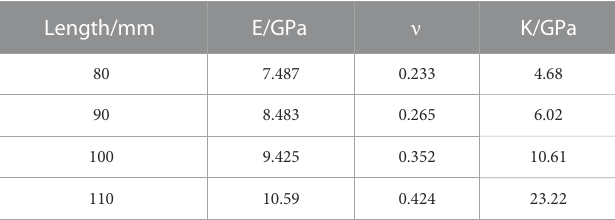
TABLE 12 Parameter values of rocks.